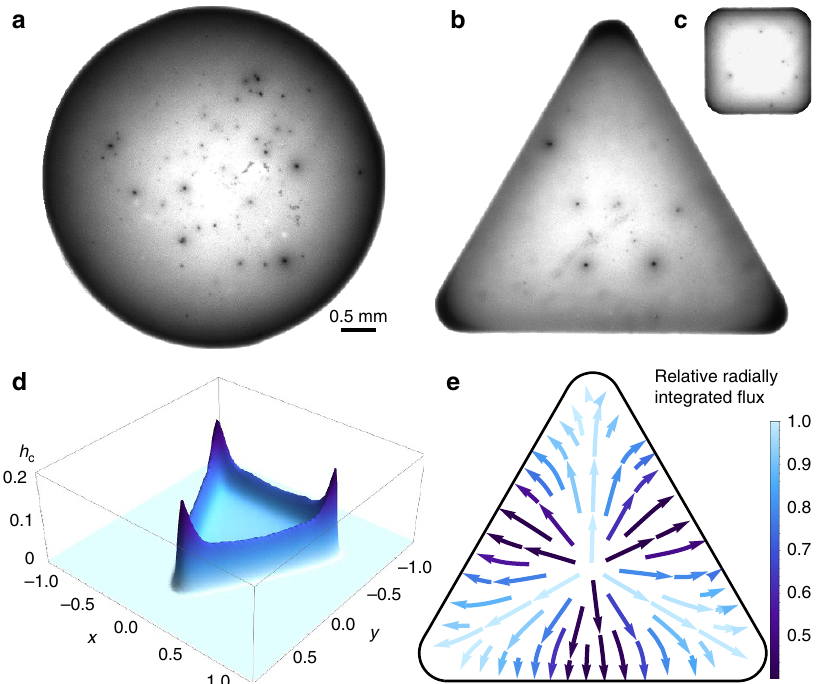
Figure 3 | Coffee ring effect in non-spherical drops. Stains left by ( a ) a spherical and ( b , c ) non-spherical sessile drops of coffee evaporating in a closed chamber at room temperature. The initial volume is V ¼ 7 m l and the contact-line perimeter is P ¼ 15mm in all cases. Non-spherical drops exhibit preferential particle deposition in contact-line regions where the curvature is higher, which contrast with the uniform ring observed with spherical drops. ( d ) Particle deposition distribution and ( e ) flow field calculated numerically for the same drop as in b . Note that in e the flow strength, which is given by the colour, represents the relative radially integrated flux R ( y )/ R ( y ) max , where R ð y Þ¼ R h 3 rr 2 h (cid:3) (cid:3) (cid:3) (cid:3) = 3 r d r , R ( y ) max is the maximum value of this across all y and h is the local drop height (see Methods for more